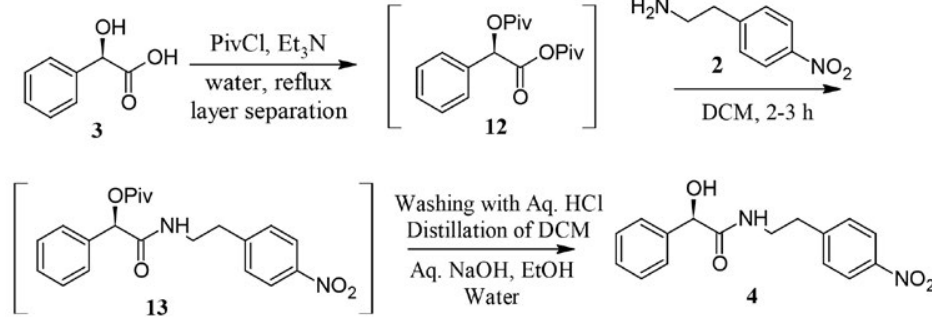
Scheme 2. Mixed anhydride approach 8 for the synthesis of the key intermediate 4